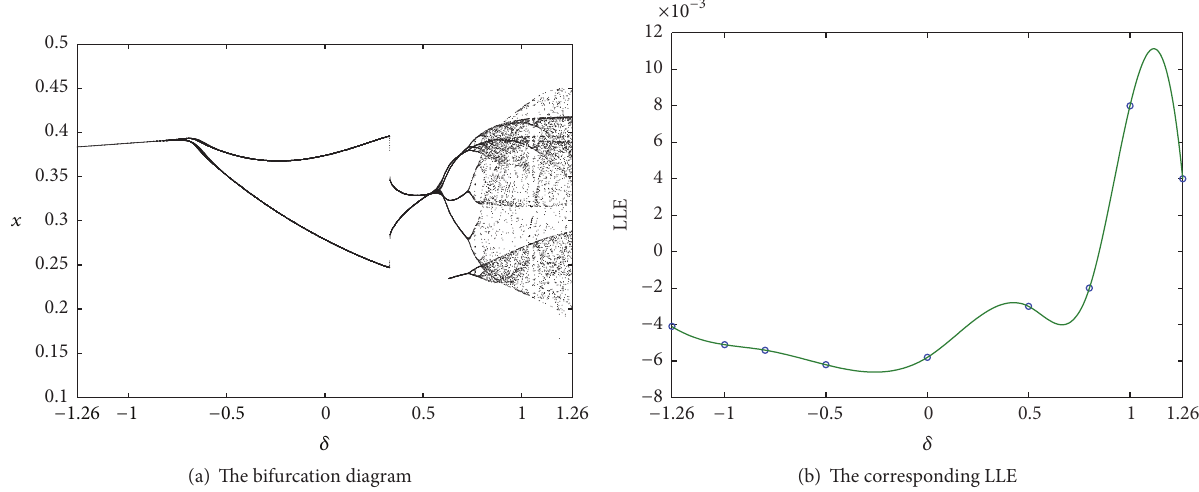
Figure 5: The bifurcation and the corresponding LLE diagrams of system (2) with the parameter 𝛿 ∈ [−1.26, 1.26]